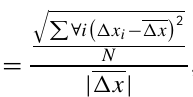
absolute values of the baseline | µ (cid:49)